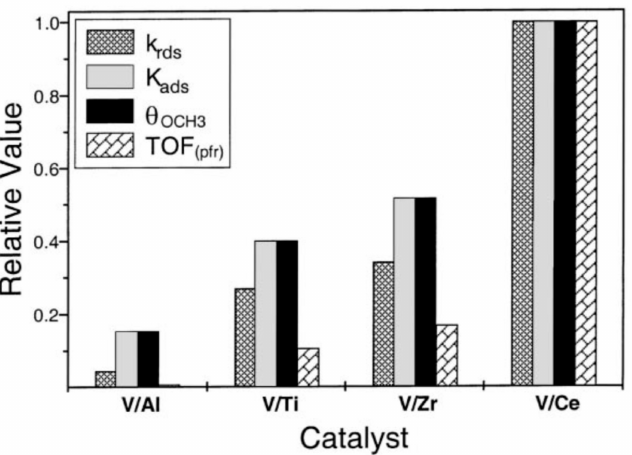
Figure 29. Relative changes in kinetic parameters, methoxy coverage, and TOF as function of support at 225 ◦ C. Reprinted from [184] Copyright © (1999), with permission from